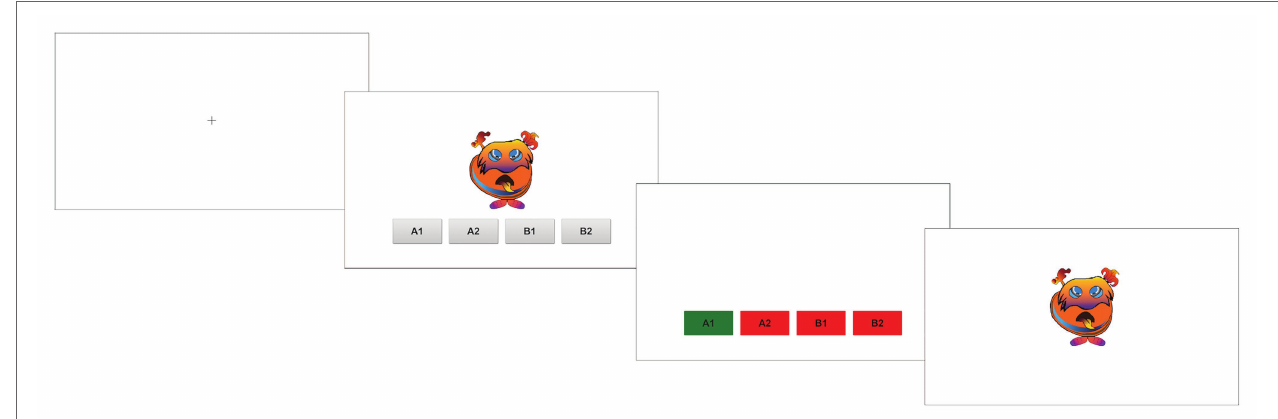
FIGURE 1 | Order of screens in a trial in the learning phase.